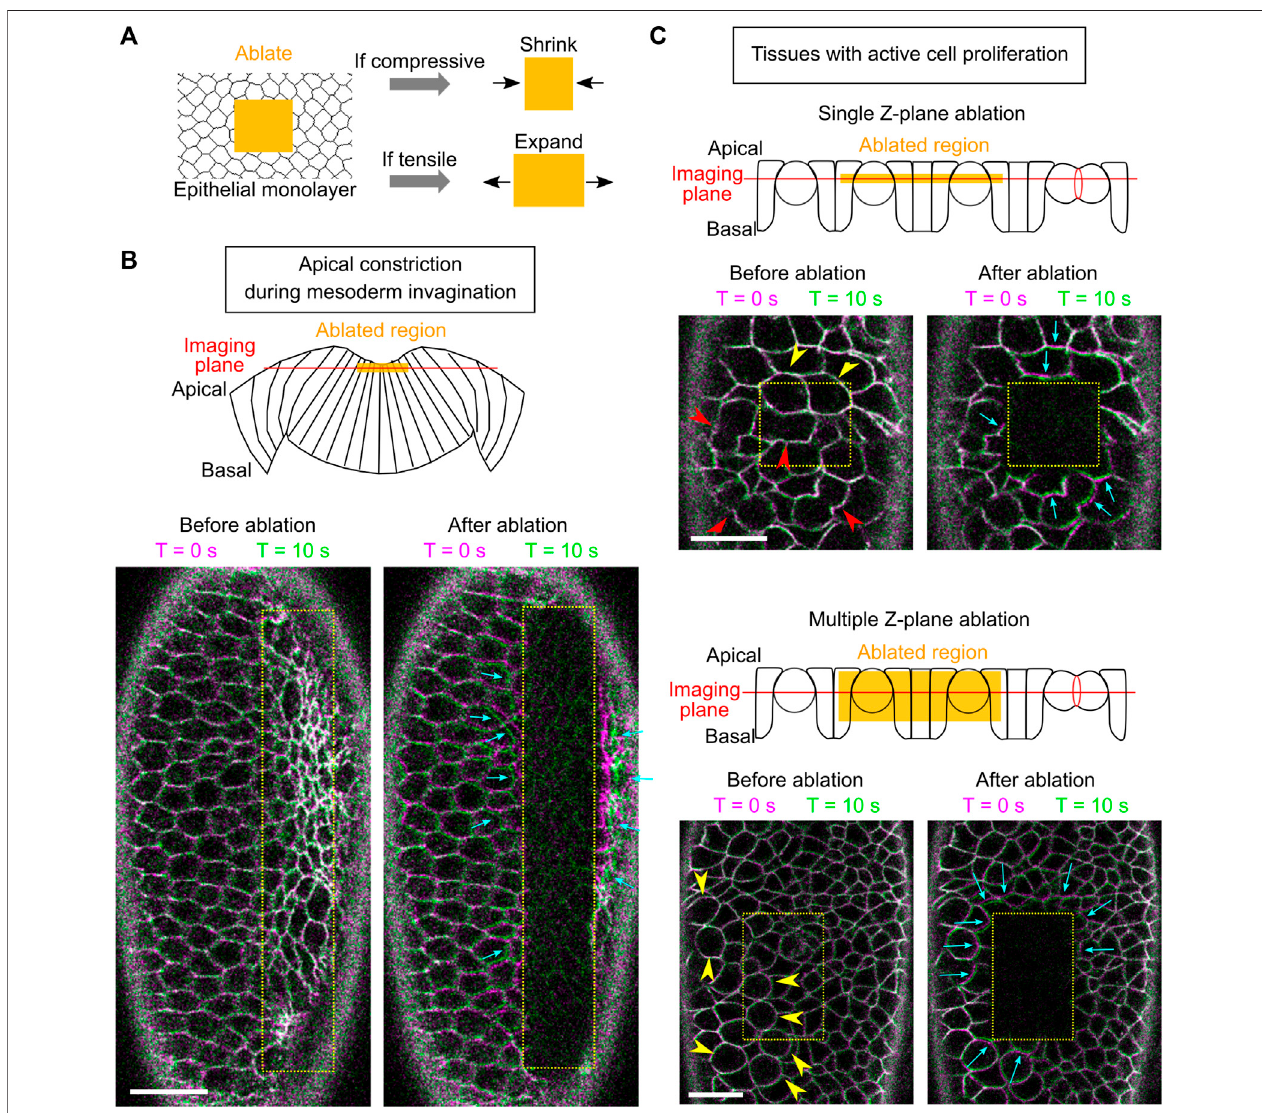
FIGURE4 | Using laser ablation to detect tissuecompression indeveloping Drosophila embryos. (A) Predicted outcome oflaser ablation when thetissueistensile or compressive. (B) Laser ablation in the mesodermal tissue during apical constriction. Ablation within the constriction domain results in recoil of the surrounding cells away from the ablated region (cyan arrows). The movement of tissues is indicated by overlaying membrane signals (Ecadherin-GFP) at T = 0 s and at T = 10 s (same in panel C ). T = 0 in the “ After ablation ” panels mark the time immediately after ablation. (C) Laser ablation within a region of the ectoderm in a stage 8 – 9 embryos where multiple cells are undergoing cell division. Cell division is indicated by mitotic rounding (yellow arrowheads) or the appearance of cleavage furrows (red arrowheads). Top: laser ablation is performed at a single z-plane approximately at the middle of the cell height. Bottom: laser ablation is performed at a series of z positions from 4 to 22 μ m deep from the surface with a step size of 2 μ m. In both cases, the surrounding cells moved towards the ablated region (cyan arrows) immediately after laser ablation. All scale bars: 20 μ m.